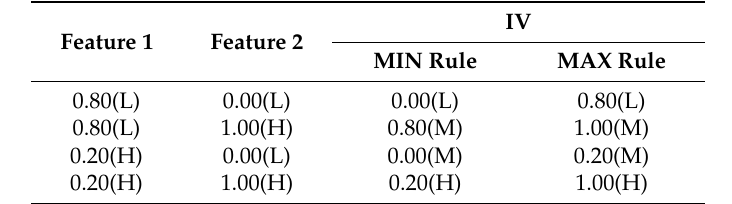
Figure 11. Obtaining the output value of the input membership function for two features: ( a ) feature 1; ( b ) feature 2.